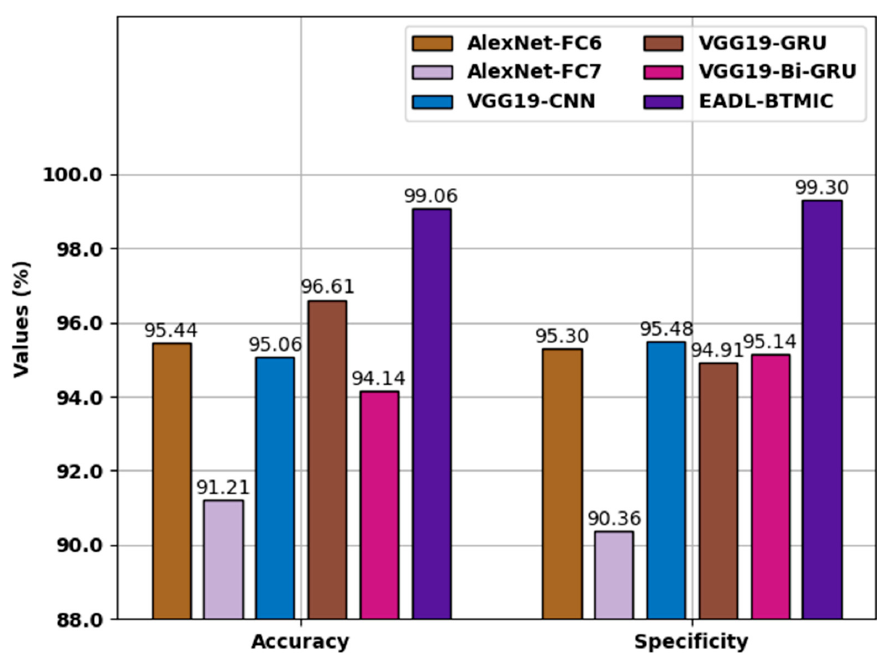
Figure 10. Accu y and spec y analysis of EADL-BTMIC technique with recent algorithms. Figure 10. 𝐴𝑐𝑐𝑢 (cid:3052) and 𝑠𝑝𝑒𝑐 (cid:3052) analysis of EADL-BTMIC technique with recent algorithms. Table 4. Comparative analysis of EADL-BTMIC approach with recent algorithms.